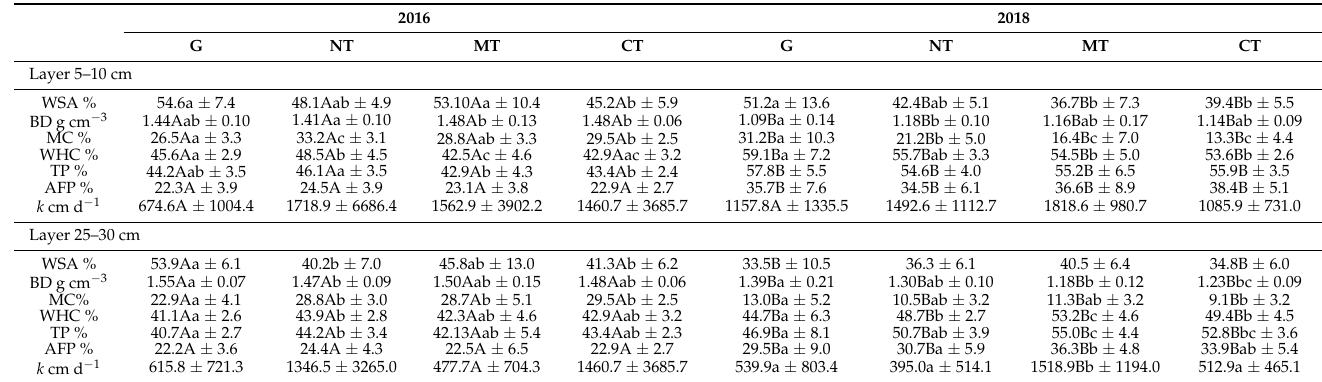
Table 3. Mean values and standard deviations of soil physical properties between different manage- ment types. Different capital letters following mean values within each layer indicate significant differences between the years within the same system ( t -test, p < 0.05). Different small letters follow- ing means indicate significant differences between management types ( p < 0.05) according to Tukey post hoc tests, and have to be read per year and soil layer (n = 96, except for aggregate stability where n = 48 for each management type and